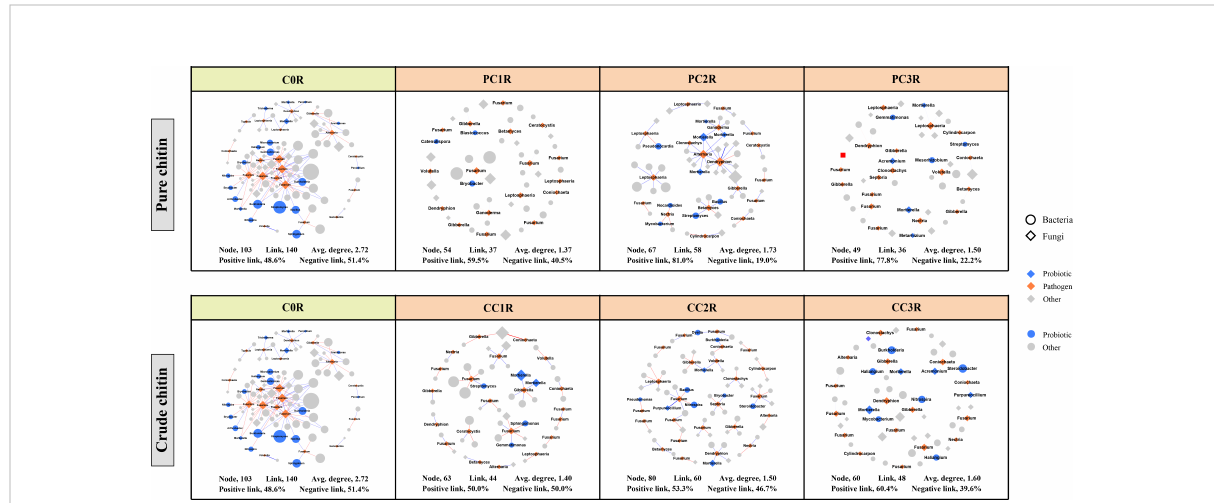
FIGURE 6 Subnetworks of potential plant pathogens separated from the microbial network under different pure and crude chitin addition dosages in the rhizosphere (R) soils. Circles and diamonds represent bacteria and fungi, respectively. The size of each node is proportional to degree. Node with blue, orange and grey indicate probiotic, pathogen and other, respectively. The microbial taxa are labeled in the blue and orange nodes. Blue and red lines show positive and negative interactions between two individual nodes, respectively. The treatment description is same as Figure 1.